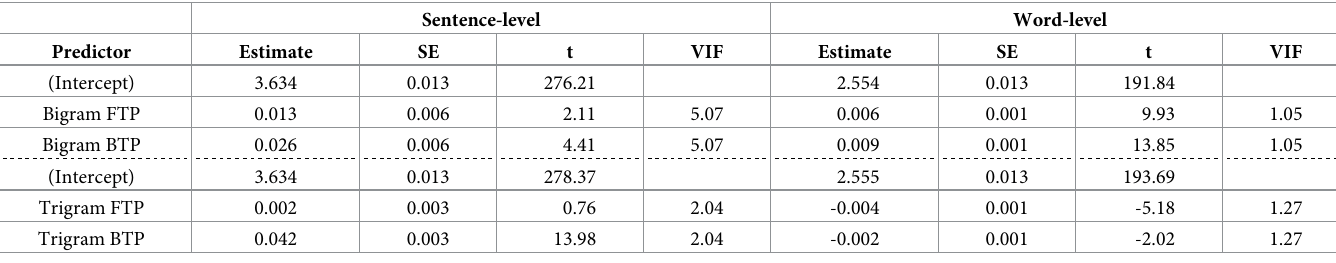
Table 7. Results of the mixed-effects model with only TP predictors.